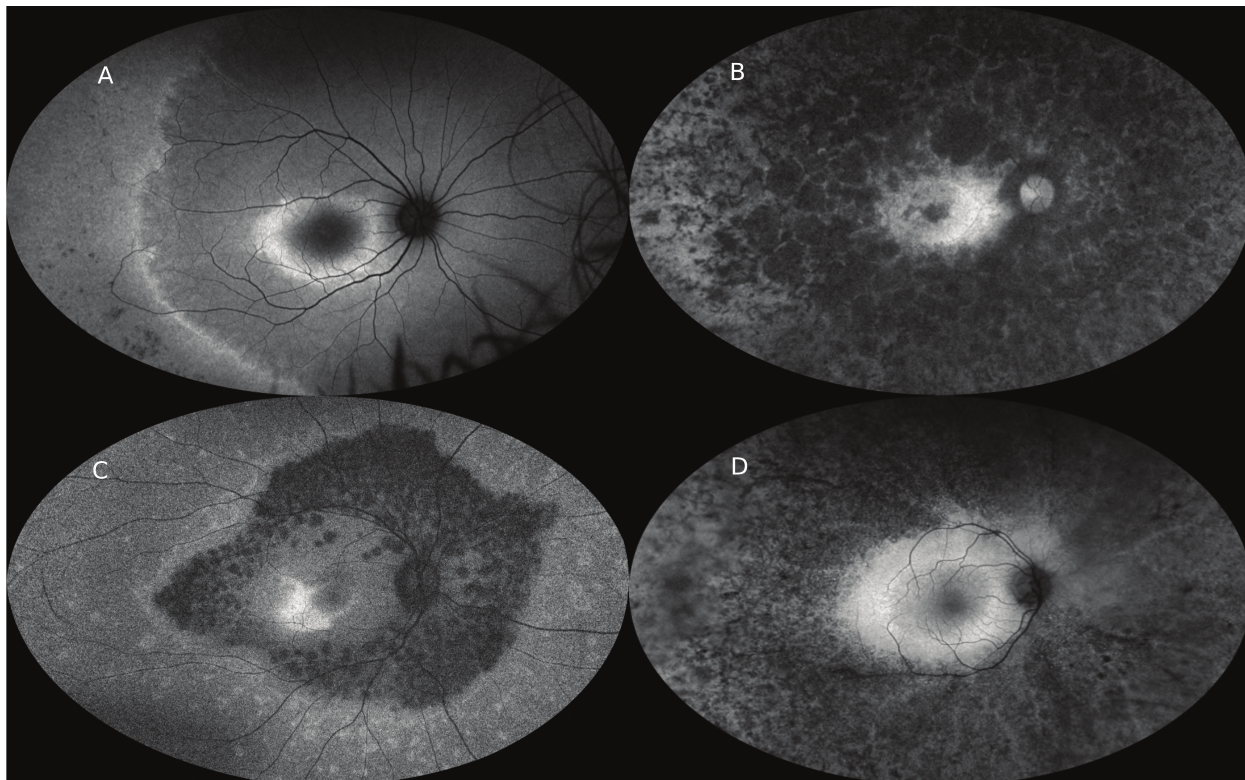
Figure 7. Green light ultrawide field fundus autofluorescence (UWF-FAF) (Optos) imaging of different patients with retinitis pigmentosa (RP). (A) Note the macular hyperautofluorescent (hyper-AF) ring and a second hyper-AF ring in the periphery. Pigment clumping can be seen in the inferotemporal periphery. (B) Note the dense peripheral nummular hypoautofluorescence (hypo-AF) indicating retinal pigment epithelial (RPE) atrophy. There is no obvious hyper-AF macular ring. (C) Note the abrupt demarcation from dense hypo-AF mottling to more uniform mild hypo-AF peripherally. There is an asymmetric hyper-AF macular ring. (D) Note dense peripheral speckled hypo-AF with preserved macular AF. There is no distinct macular hyper-AF ring. Note that in (A) and (C), despite widespread peripheral photoreceptor loss and dense visual field constriction clinically, in there is preservation of some FAF signal peripherally and therefore incomplete RPE